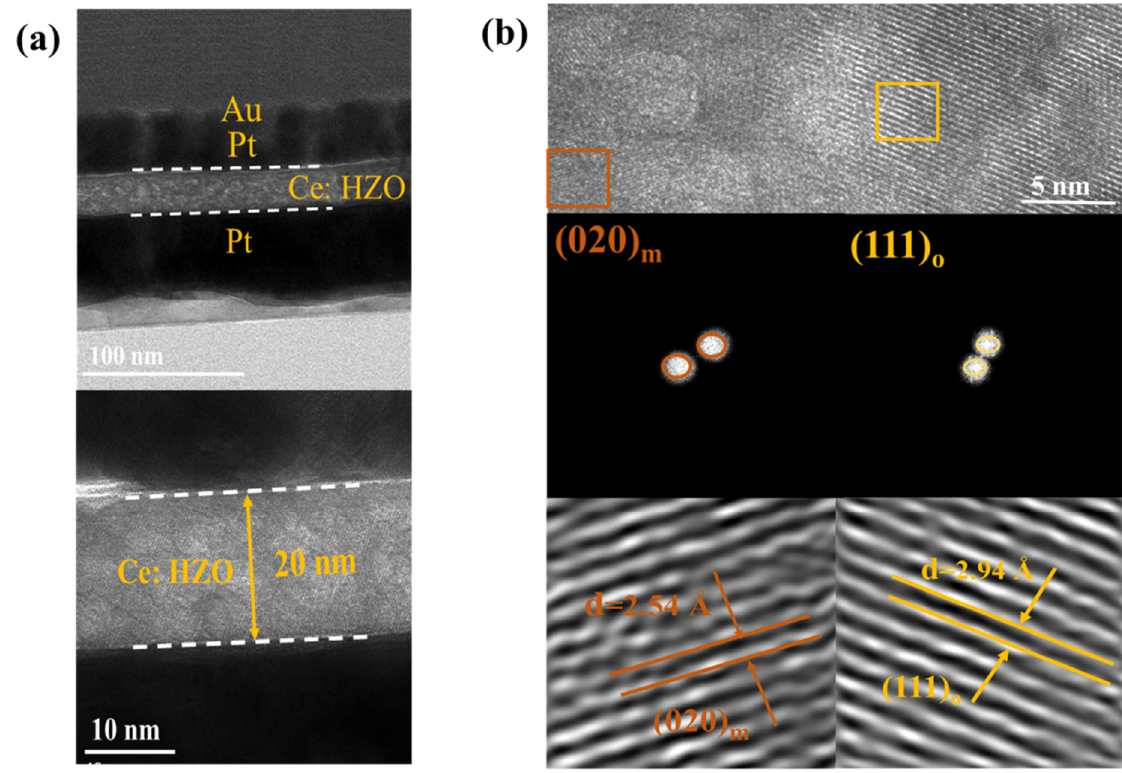
Figure 4. ( a ) TEM images of the Pt/Ce: HZO/Pt metal–ferroelectric–metal (MIM) structure; ( b ) cross- sectional HRTEM image of the 7 mol% Ce doping HZO films.